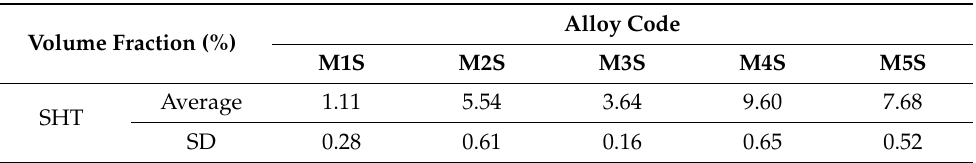
Table 3. Volume fractions (%) of undissolved intermetallic compounds in the matrix of as-quenched alloys following solution heat treatment